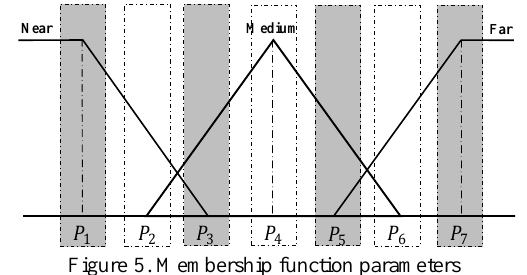
Figure 5. Membership function